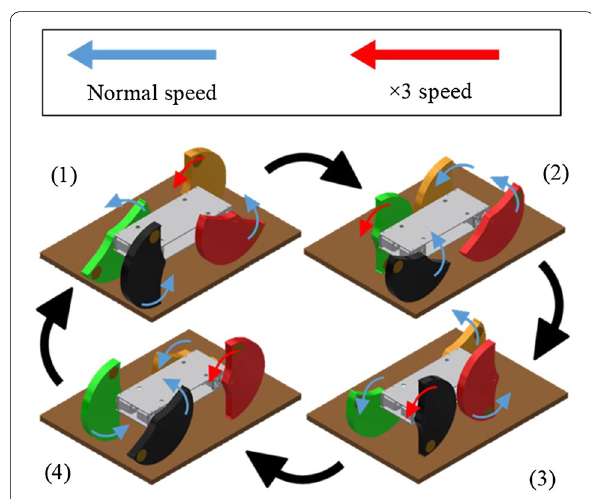
Fig. 8 Step climbing (190 mm)